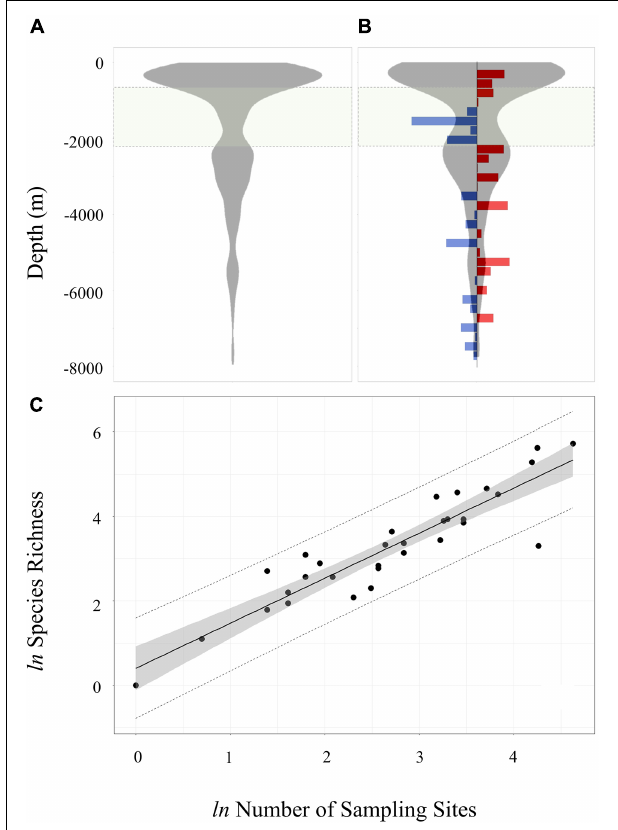
FIGURE 2 | Density plot of (A) record counts and (B) species richness by depth. Species richness is calculated as number of distinct species per 250 m depth bin. The species richness plot includes residuals for each 250 m depth bin derived from the linear regression of log transform species and station counts shown in panel (C) . Blue bars in panel (B) denote negative residuals (relative species paucity), and red bars denote positive residuals (relative species richness). The light green shared zone between 700 and 2,250 m denote the depth range open to licenced long-line fishing. In panel (C) the regression line is shown in solid black ( r 2 = 0.84), the 95% regression confidence interval as grey ribbon and the 95% prediction line as a dashed black line. Log transformed data was tested for normality (Shapiro–Wilk P >